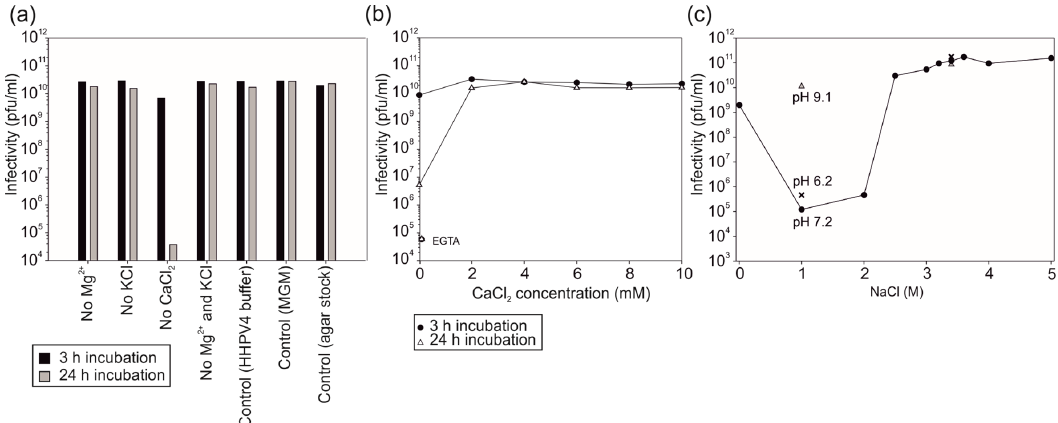
Figure 1. Haloarcula hispanica pleomorphic virus 4 (HHPV4) infectivity in different ionic conditions. ( a ) Infectivity in HHPV4 buffer (3.4 M NaCl, 120 mM MgSO 4 , 110 mM MgCl 2 , 70 mM KCl, 4 mM CaCl 2 , 50 mM Tris-HCl, pH 7.2) from which one or two components at a time have been removed. Infectivity was assayed after 3 h (black bars) and 24 h (grey bars) incubation at 4 °C. Modified growth medium (MGM) and agar stock were used as controls; ( b ) The effect of CaCl 2 concentration in HHPV4 buffer on virus infectivity after 3 h (circles) and 24 h (triangles) incubation at 4 °C. Chelating agent EGTA was used to remove residual CaCl 2 ; ( c ) The effect of NaCl concentration in HHPV4 buffer (pH 7.2) on virus infectivity after 7 d incubation at 4 °C (circles). Virus infectivity in HHPV4 buffer at pH 6.2 (crosses) and pH 9.1 (triangles) in the presence of 1 M and 3.4 M NaCl were assayed in the same incubation conditions. Pfu, plaque-forming